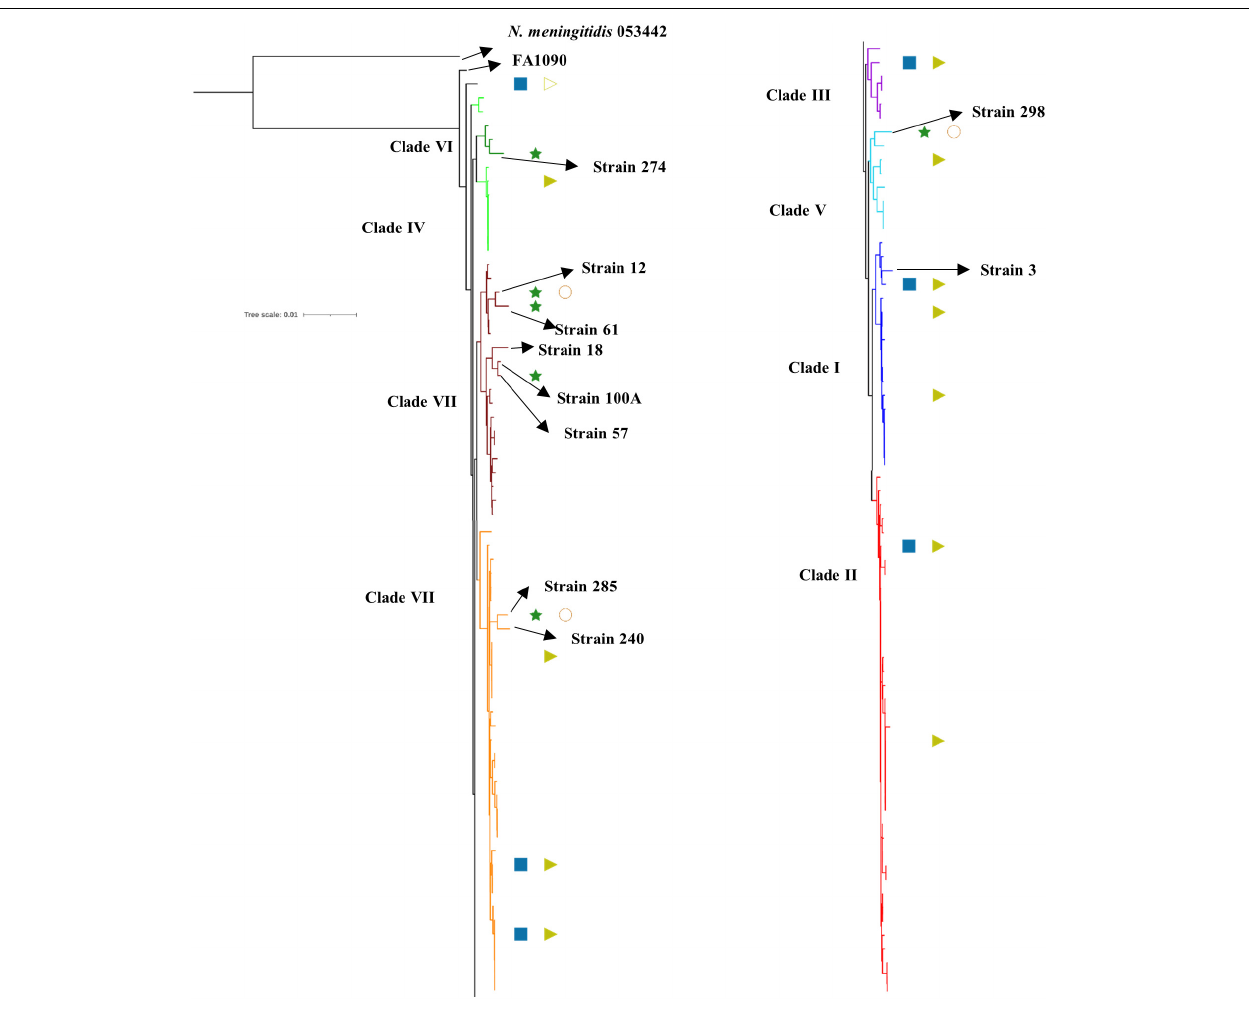
FIGURE 2 | Phylogenetic tree of the sequenced strains with previously reported strains from Kenya. The antibiotic resistance profile, wherever available, has been indicated as metadata (Penicillin – blue rectangle, Ciprofloxacin – dark green star, Tetracycline – right-pointing light green triangle, Gentamycin – orange circle, Filled shape – resistant, outline shape – intermediate resistant, no shape – susceptible). The clades inferred from the phylogeny analysis have been indicated in different colors and numbered I–VIII as per Figure 1 . The strains sequenced in this study, the reference strain for N. gonorrhoeae (FA1090), and an N. meningitidis strain (PubMLST id:053442) used as an outgroup for the analysis have been labeled and indicated with